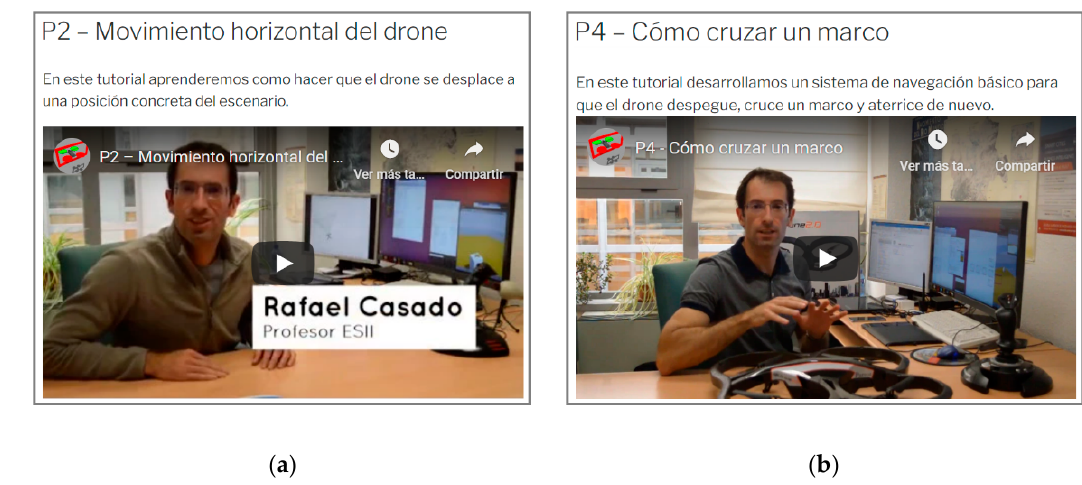
Figure 18. Examples of video tutorials available on the competition website: ( a ) Horizontal drone movement; ( b ) How to cross a frame.